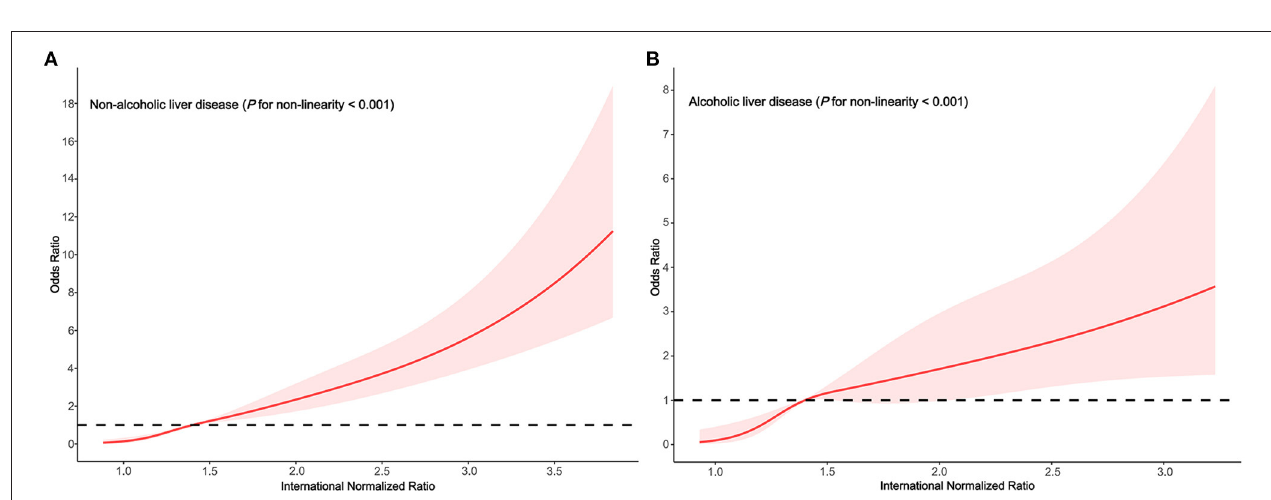
FIGURE 2 | Association between the INR and HE risk based on restricted cubic spline model in total population.